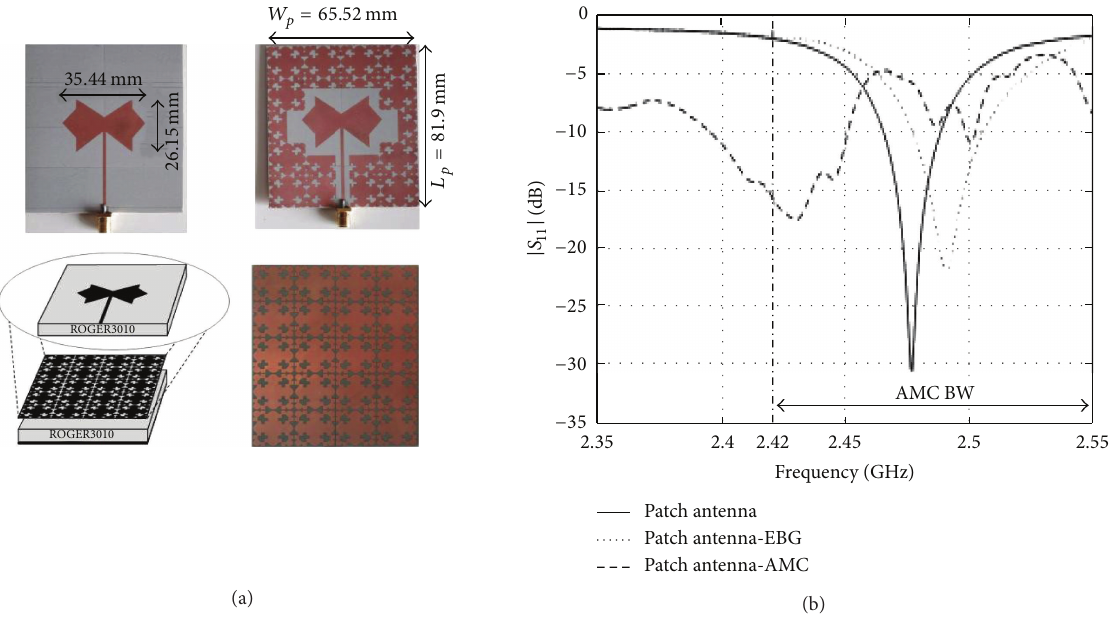
Figure 20: (a) In clockwise: reference antenna, EBG-antenna, AMC surface, and AMC antenna; (b) comparison of their return loss